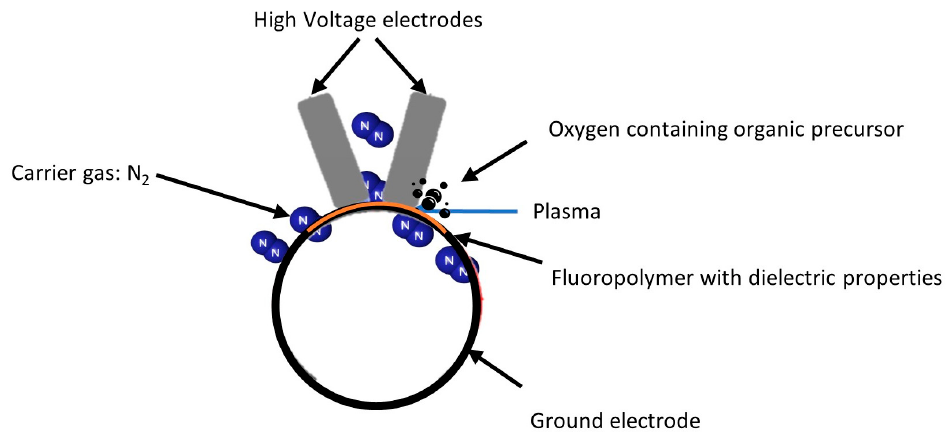
Figure 1. Experimental set-up, semi-industrial